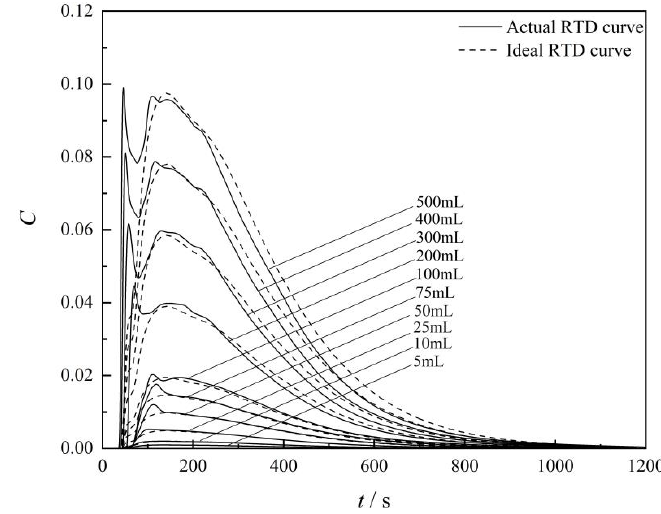
Figure 9. RTD curves for the different tracer solution volumes.